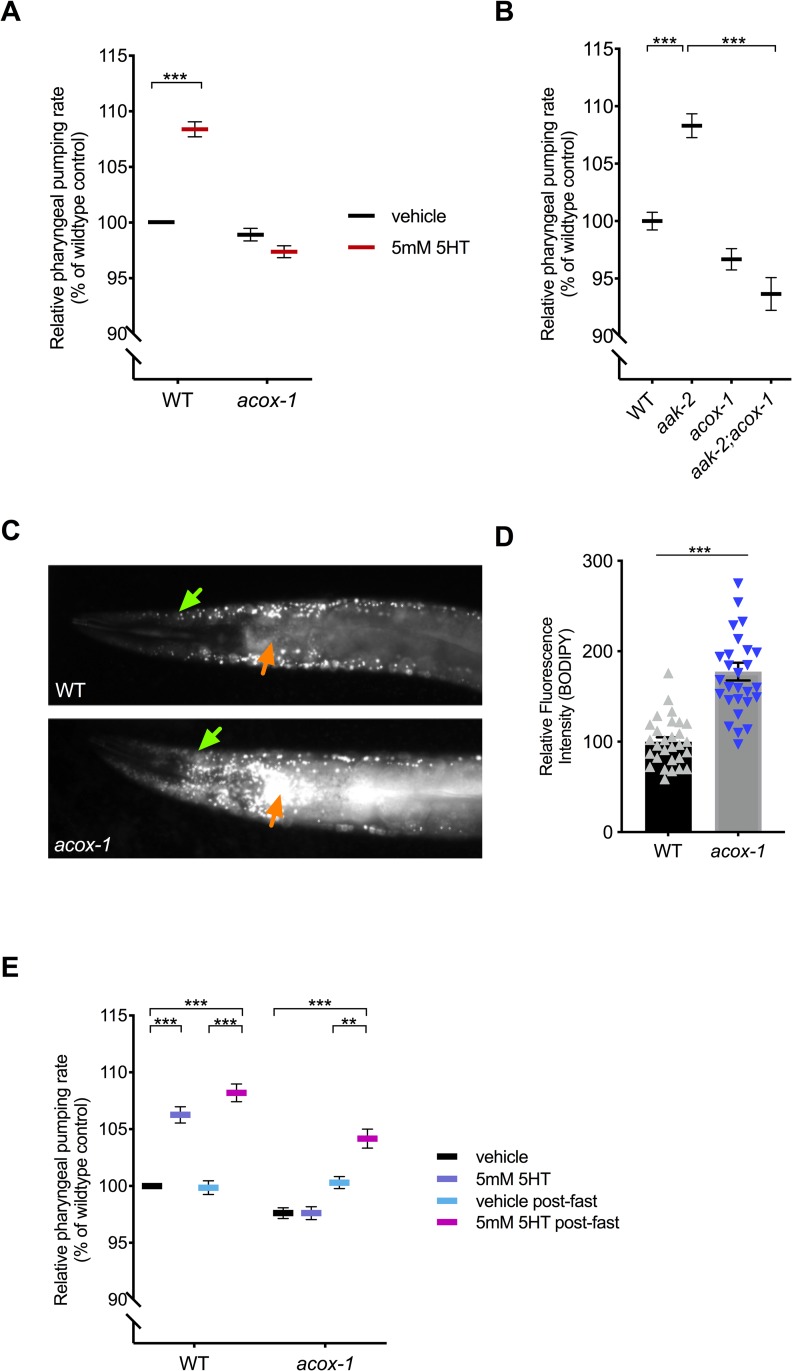
acox-1 mutants are insensitive to the feeding stimulatory effects of serotonin.(A)
acox-1(ok2257) mutants are resistant to pharyngeal pumping increasing effects of 5 mM serotonin. (B) Loss of acox-1 suppresses the elevated feeding rates of aak-2 animals. All feeding data are normalized to vehicle-treated wild-type animals and are presented as a percentage of wild-type rates. In both (A) and (B), error bars indicate ±SEM from normalized mean, n = 50 animals per strain. ***p < 0.0001 ANOVA (Tukey). (C and D)
acox-1 mutants accumulate significantly more fat than wild-type animals as assessed by epidermal (green arrows) and intestinal (orange arrows) BODIPY fluorescence levels. Representative images of BODIPY staining (C) and corresponding quantifications of epidermal BODIPY fluorescence levels (D) ***p < 0.001, Student t test. (E) Fasting acox-1 mutants for 90 minutes restores their ability to elevate feeding in response to 5 mM serotonin. Day 1 adult animals were either fed ad libitum or fasted for 90 minutes, then plated on vehicle or 5 mM 5HT plates for 60 minutes before assessing pharyngeal pumping rates. Error bars indicate ±SEM from normalized mean, n = 15 animals per condition. **p < 0.01, ***p < 0.001 ANOVA (Tukey). See S1 Table and S1 Data for underlying data. aak-2, AMP-activated kinase alpha 2; acox-1, acyl-coenzyme A oxidase 1; BODIPY, boron dipyrromethene; WT, wild-type; 5HT, 5-hydroxytryptamine.